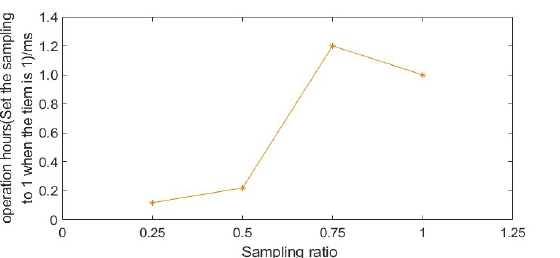
Figure 3. Comparison of running times of different